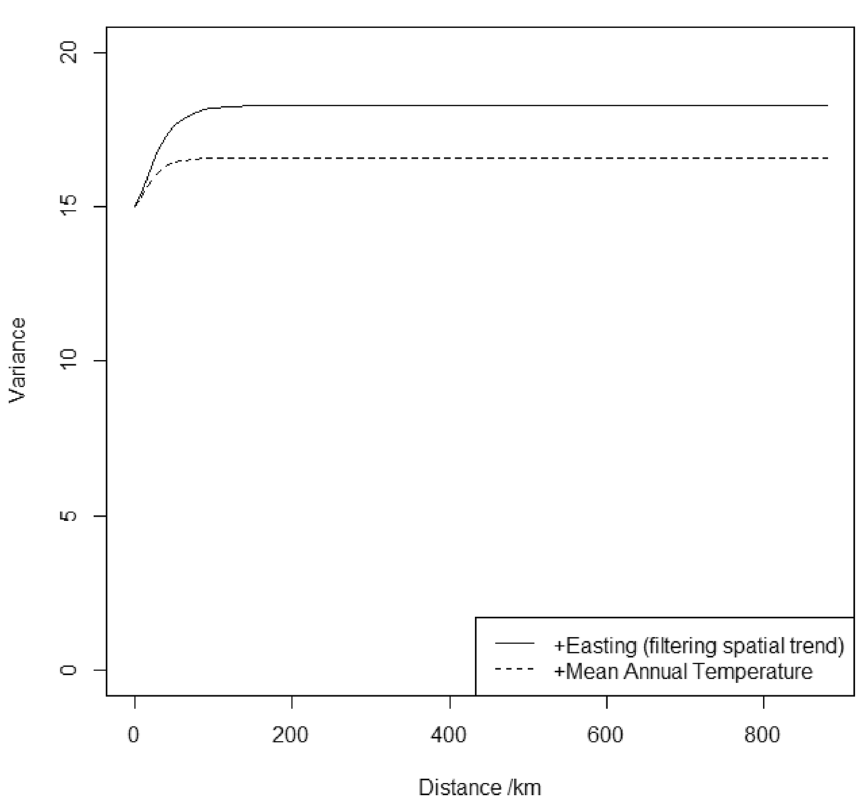
Figure 3. Variogram functions for the null model (eastings only) for maize grain zinc concentration, and for successive models with selected environmental covariates added as